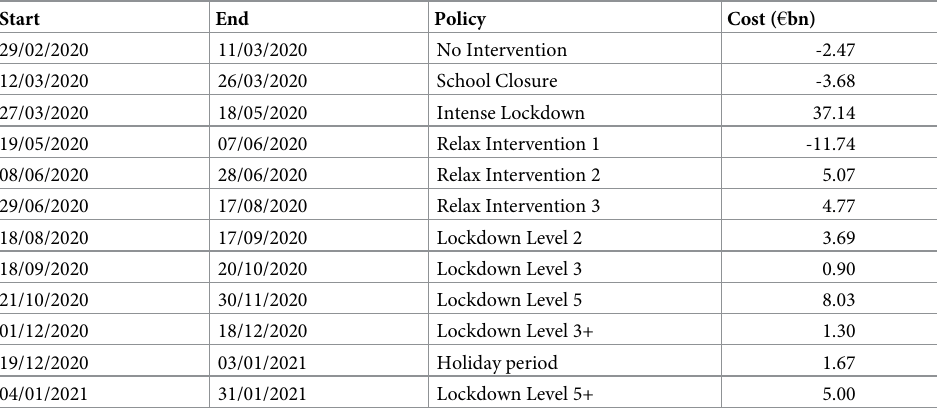
Table 2. Estimated economic costs for each lockdown period.